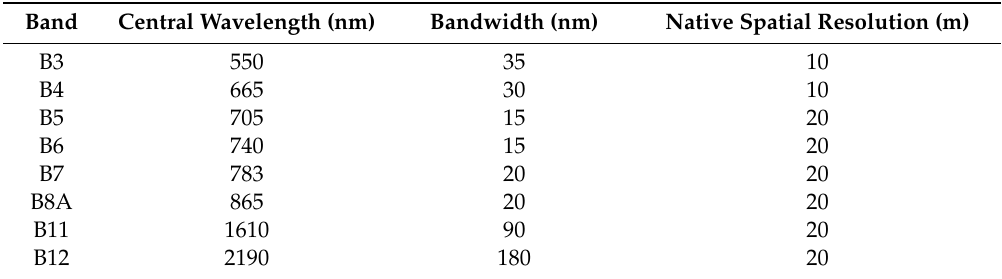
Table 3. MSI bands adopted by the SNAP L2B and INFORM-based retrieval